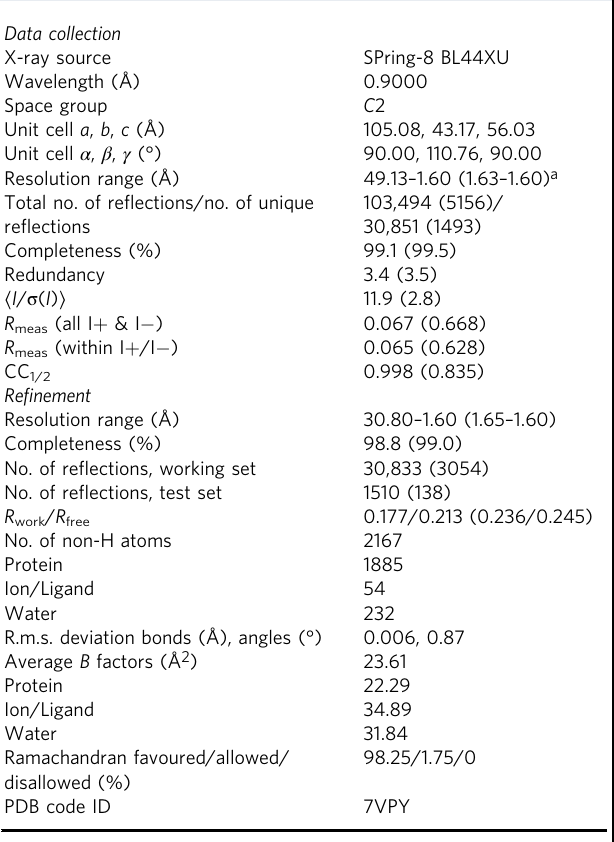
Table 2 Crystallographic data collection and re fi nement